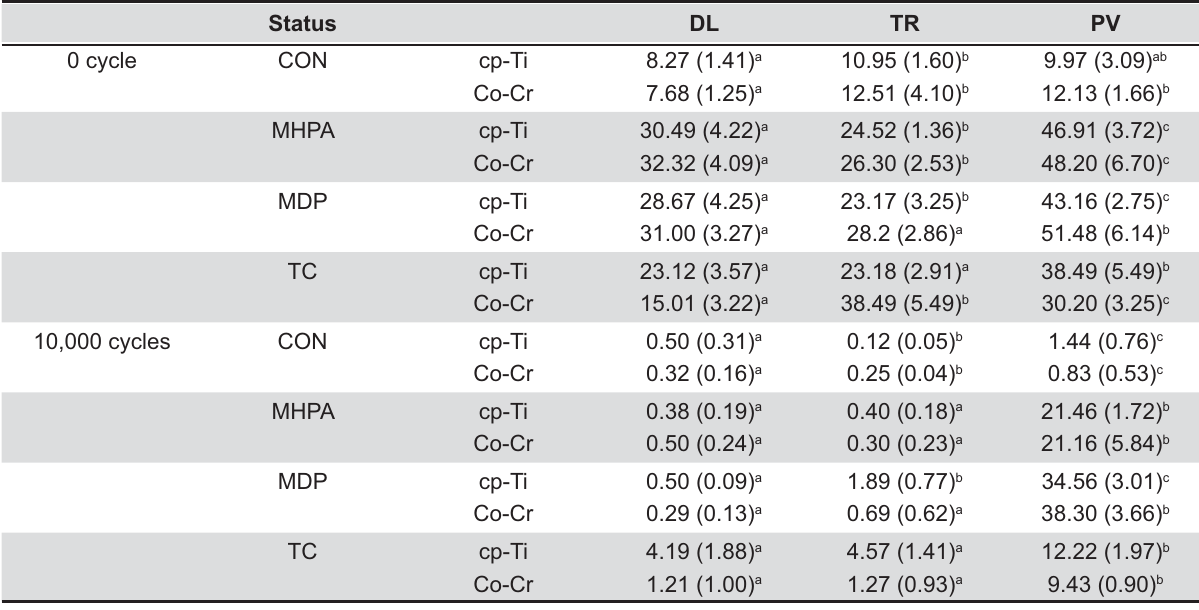
Table 1- Bond strength results (MPa)